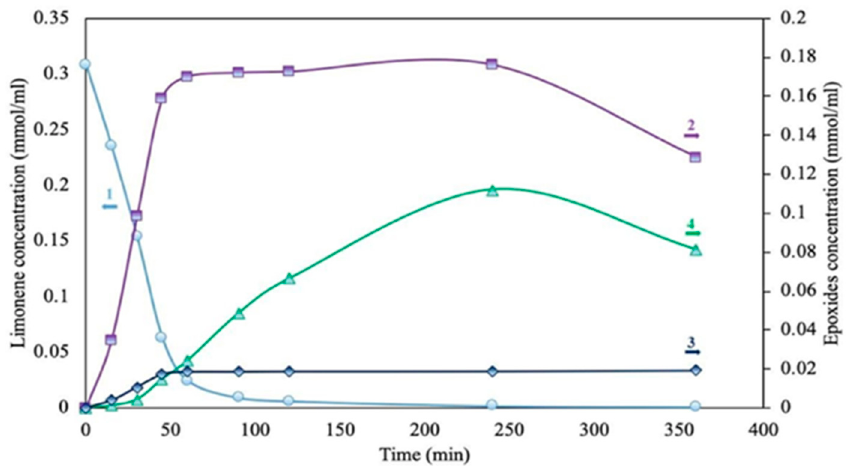
Figure 4. Limonene conversion (1), 1,2-limonene oxide (2), 8,9-limonene oxide (3) and limonene dioxide (4) selectivity versus time. Reproduced from Ref. [52] with permission from Royal Society of Chemistry.